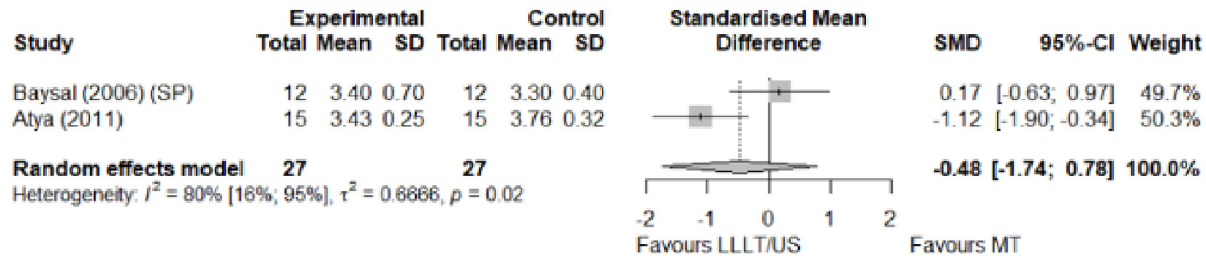
Fig 16. Analysis—Electrophysical modalities versus manual therapy (sensory latency). Studies delivering modalities with a splint were marked as (SP).